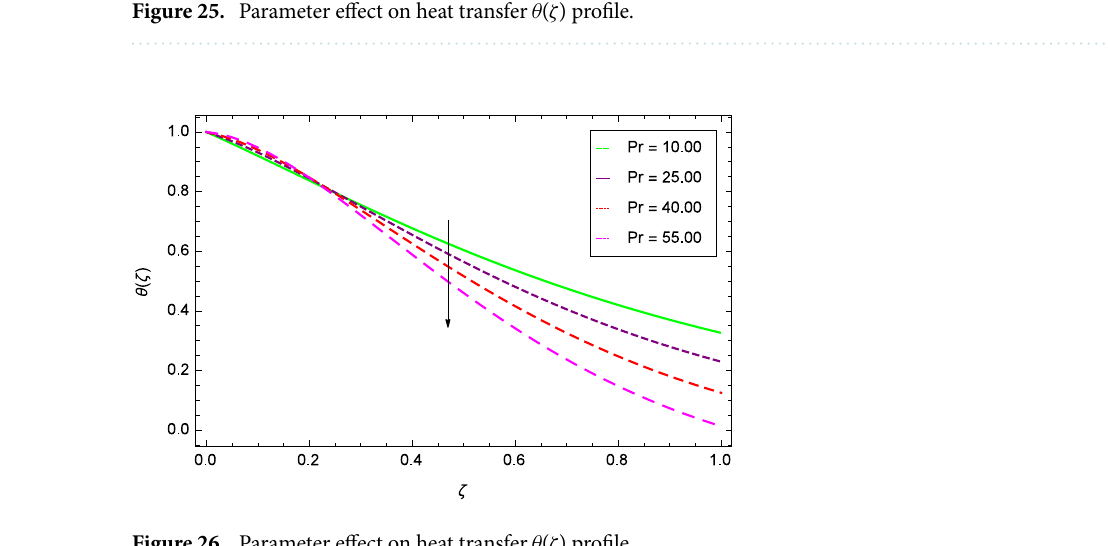
Figure 26. Parameter effect on heat transfer θ ( ζ ) profile.